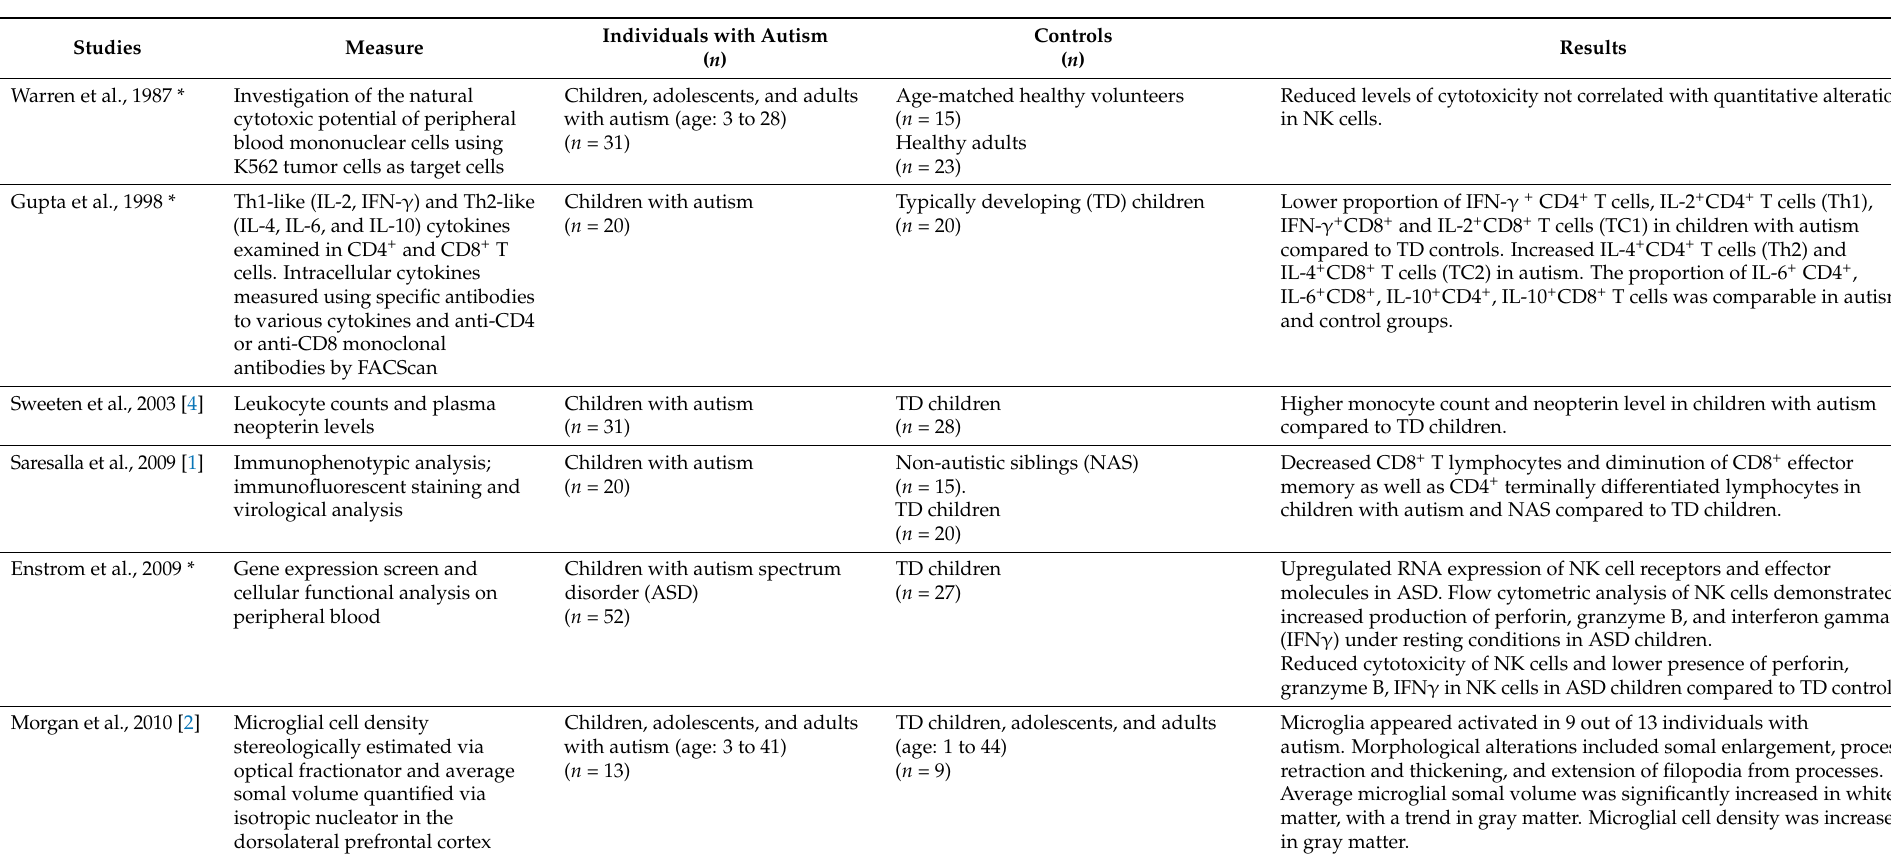
Table 1. Studies of immune cell abnormalities in